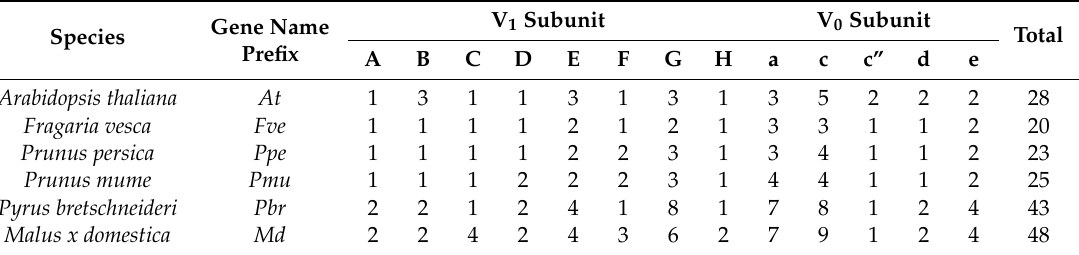
Table 1. Numbers of VHA genes in Arabidopsis thaliana and five Rosaceae